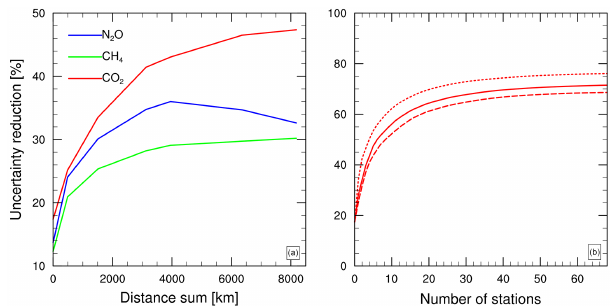
Figure 7. (a) Uncertainty reduction for the three GHGs (red: CO 2 ; green: CH 4 ; and blue: N 2 O) with respect to the total distance to As- pendale for the five stations in the network extension and (b) uncer- tainty reduction for CO 2 for the default case (solid line), increased observational uncertainties SE2 (dashed line) and observational un- certainty for all stations set to almost zero (dotted